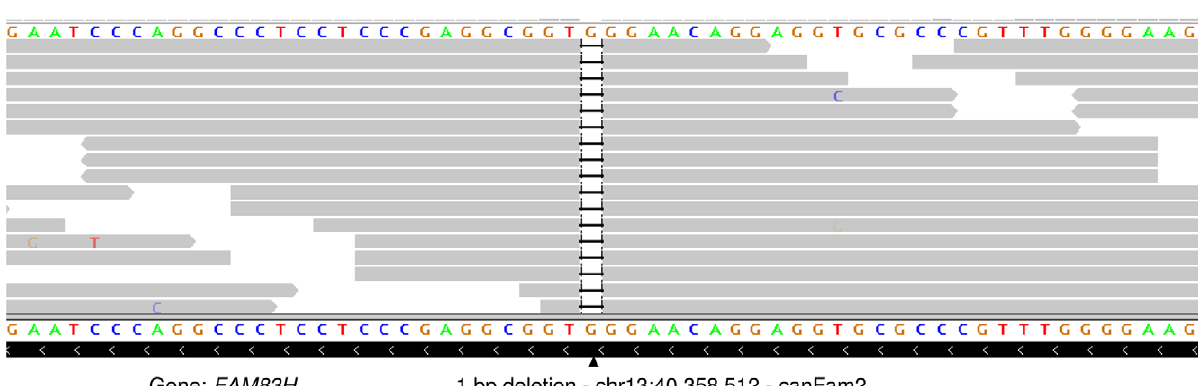
Figure 4. IGV display of the 1 bp deletion in exon 5 of FAM83H .